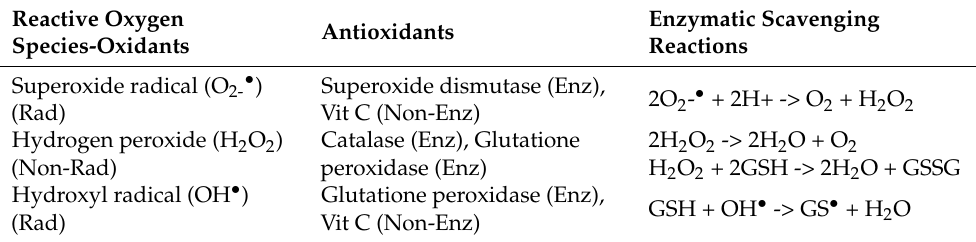
Table 1. The most common reactive oxygen species, antioxidants and respective scavenging reactions. Reactive